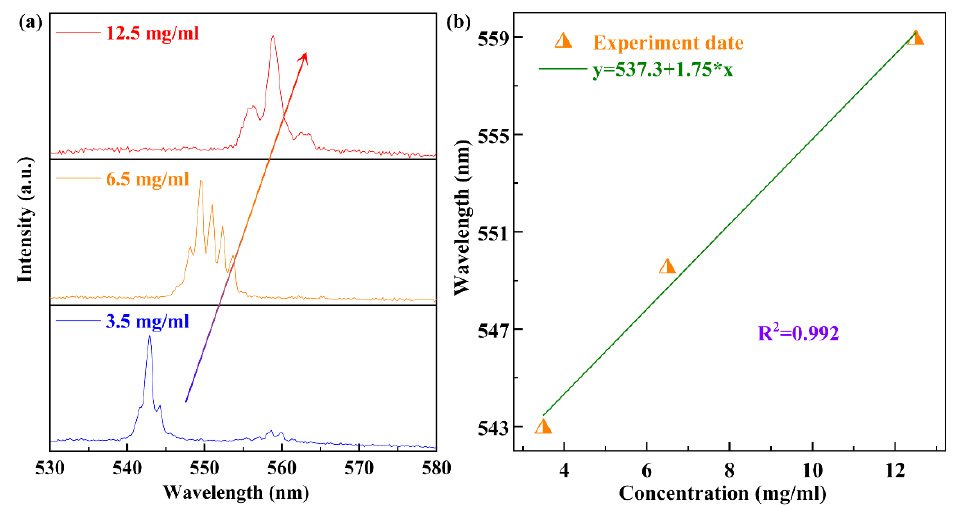
Figure 4. ( a ) The evolution of the WGM lasing of spectrum with different gain concentration from 3.5 mg/mL to 12.5 mg/mL. ( b ) The relationship between gain concentration and emission wavelength.